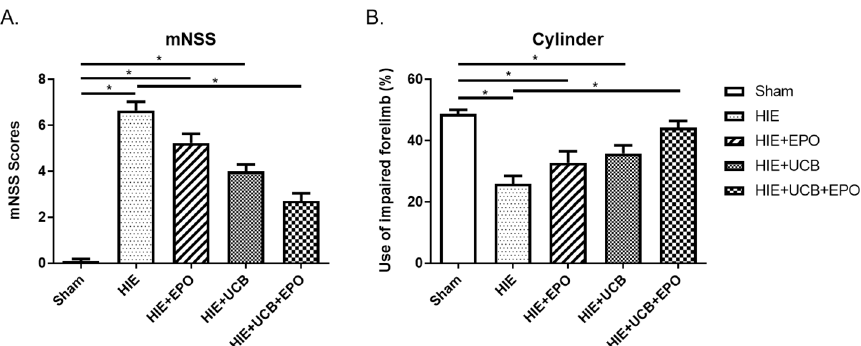
Figure 1. Neurobehavioral improvement after rhEPO, hUCB, and combination treatment of rhEPO and hUCB in HIE model. ( A ) The graph represents mNSSs (0 (normal)~14 (severe injury)) in each group. ( B ) The graph represents the percentage of impaired forelimb use in each group. Sham (normal); HIE (hypoxic–ischemic encephalopathy); HIE+EPO (500 IU/kg of rhEPO, intraperitoneal injection for five consecutive days from 7 d after HIE); HIE+UCB (3 × 10 7 /kg of hUCB, intraperitoneal injection once at 7 d after HIE); HIE+UCB+EPO (combination of hUCB and rhEPO treatment on HIE). Data shown as the mean ± standard error of mean. n = 9 per group. * p < 0.05 (( A ) Kruskal–Wallis; ( B ) one-way ANOVA).